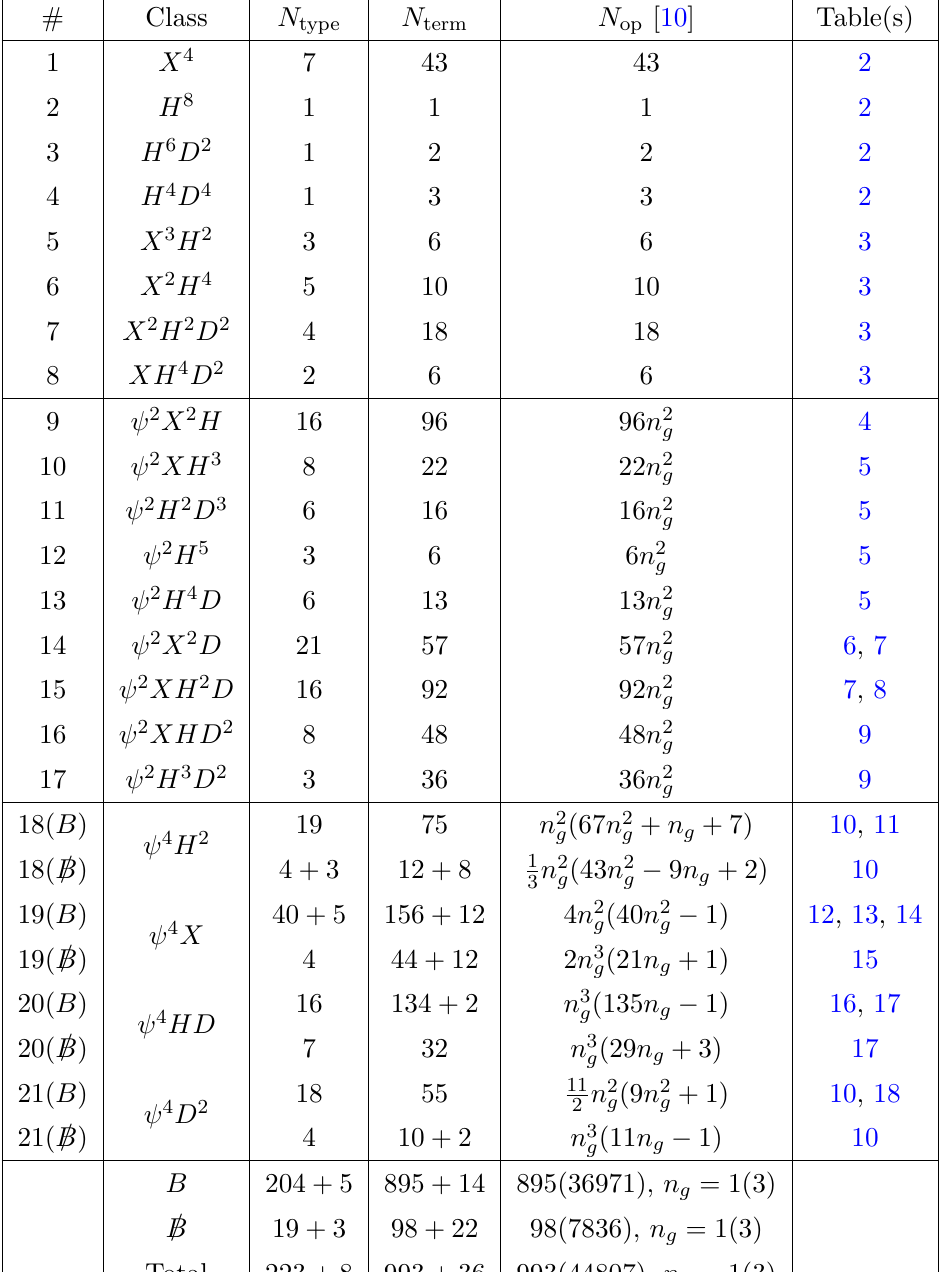
Table 1 . Summary of the contents of the tables to follow. The links in the rightmost column point to the table(s) of results for a given class. The number of types of operators and the number of Lagrangian terms in the class are given in the third and fourth columns from the left, respectively. For comparison the number of operators from ref. [10] is given in the second column from the right. Lines separate the classes based on the number of fermions in the class. Four-fermion operators are further divided into subclasses either preserving or violating baryon number. Additionally the number to the right of the + sign in N for the four-fermion operators is the number of type(term) types(terms) that vanish in the absence of (cid:13)avor structure.